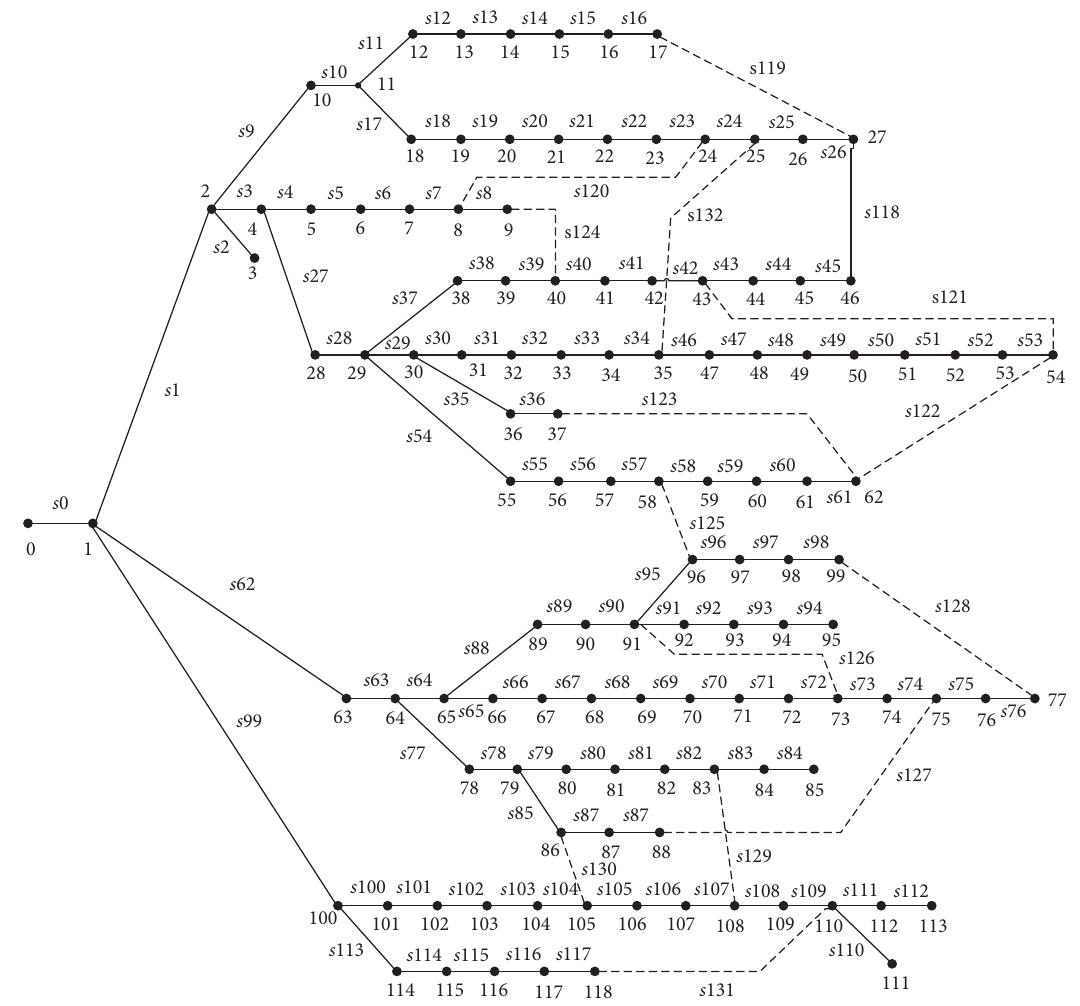
Figure 9: Single-line diagram of the 119-bus system. Table 4: Result comparison of CSFSA with other methods for the 119-bus